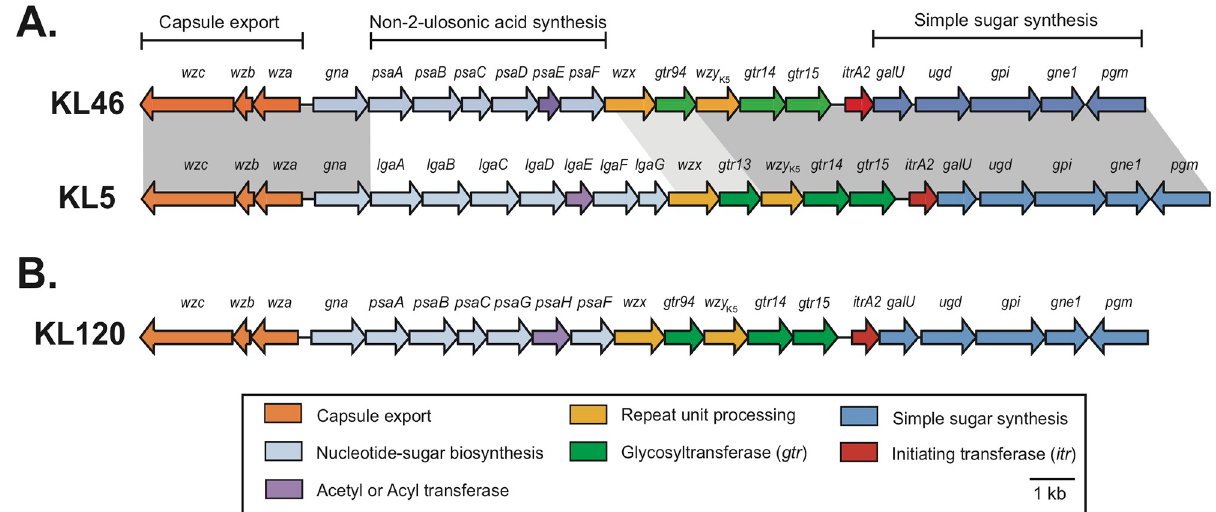
Fig 1. A. Comparison of the KL46 and KL5 capsular polysaccharide biosynthesis gene clusters of A . baumannii NIPH 329 and SDF, respectively. Modules of genes required for specific processes in CPS synthesis are indicated above. Dark shading between the gene clusters indicates > 95% and light grey shading 80–95% nucleotide sequence identity. B. Organisation of the KL120 gene cluster that is similar to KL46. Colour scheme for the genes shown below indicates the functions of the encoded gene products. Figure is drawn to scale from GenBank accession numbers MK609549. 1 (KL46), CU468230.2 (KL5; coordinates 61721 to 89706), and LLCR01000062.1 (KL120; coordinates 12963 to